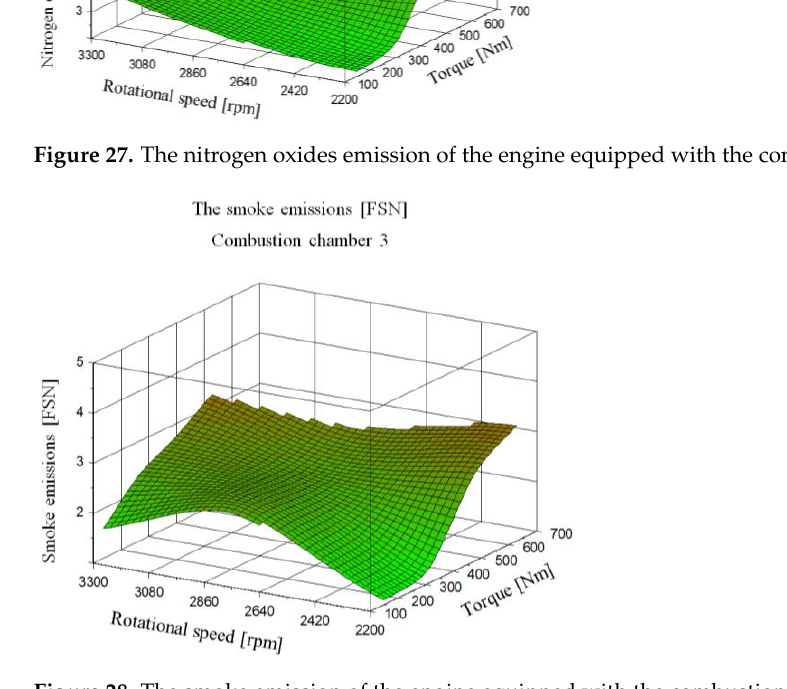
Figure 27. The nitrogen oxides emission of the engine equipped with the combustion chamber 3.